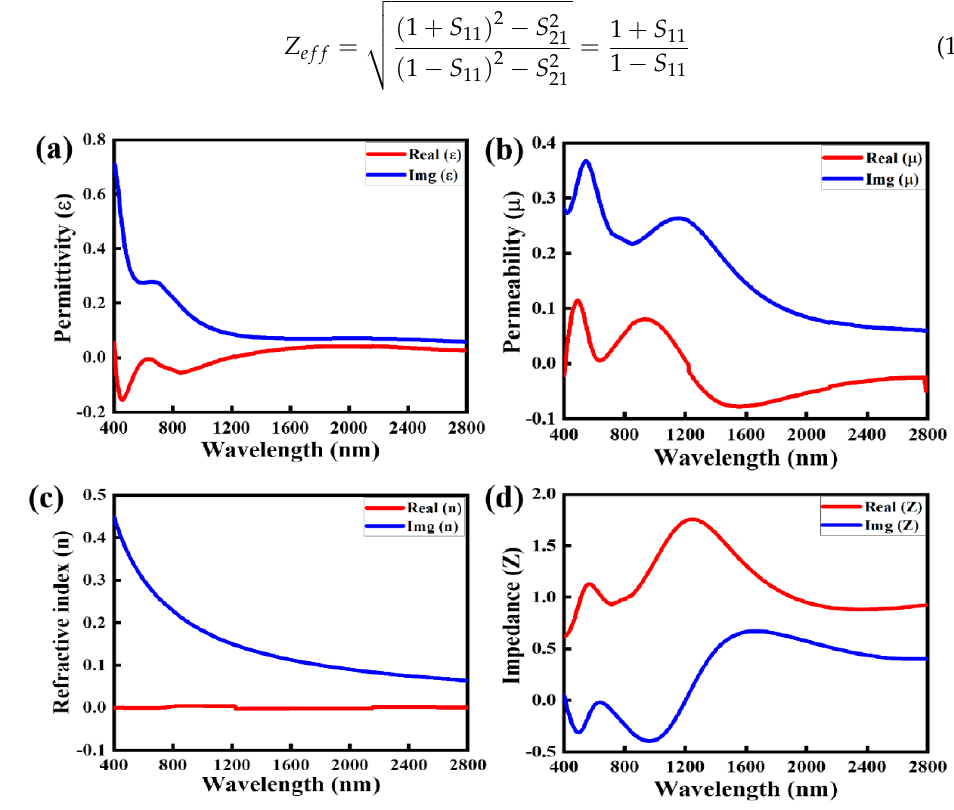
Figure 3. Optical material parameters of the proposed NMMA: ( a ) complex value of permittivity (ε) , ( b ) complex value of permeability (µ), ( c ) complex value of refractive index (n), and ( d ) complex value of the impedance (Z).